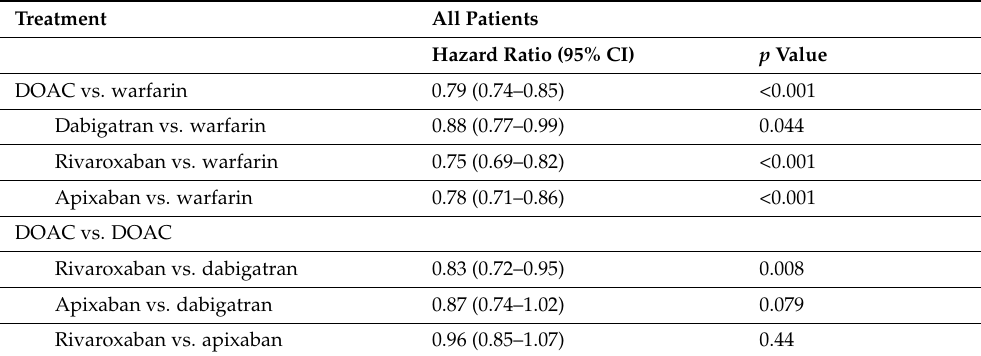
Table 3. Relative risk of osteoporosis after IPTW.